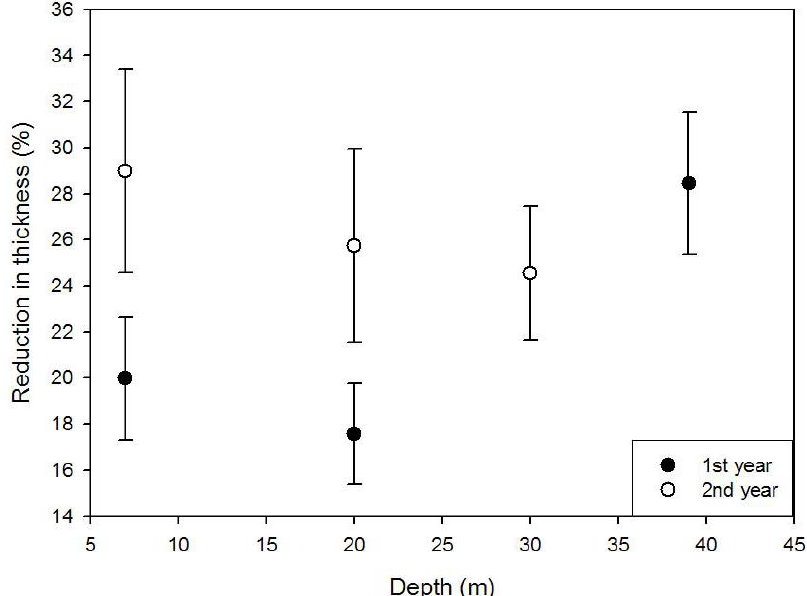
Figure 6. Percentage reduction in the thickness of nacre layers as a function of depth (m). The error bars represent the standard deviation of the reduction in thickness. We analyzed 5 shells for each depth and measured 10 points in each shell.